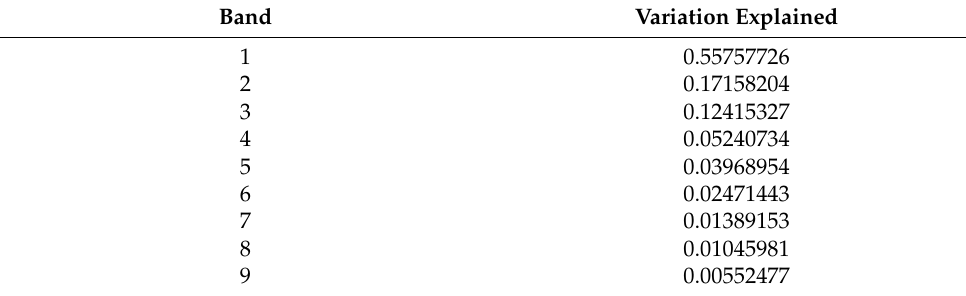
Table A6. ULS PCA band variation explained at 0.5 m grid size.